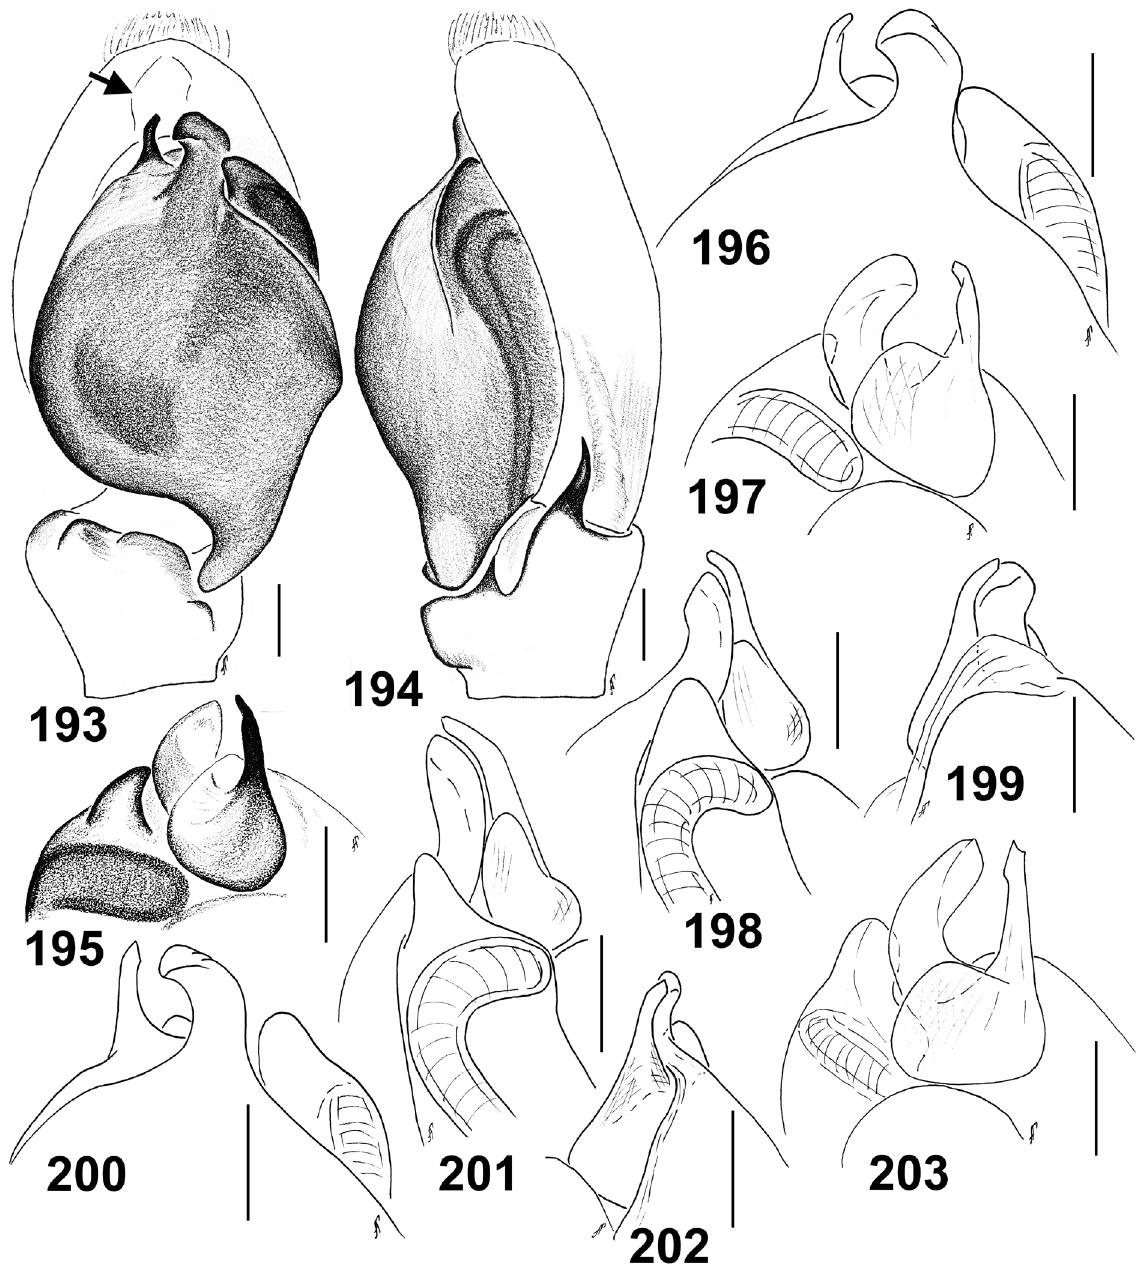
Figs 193–203. Male palp of Stenaelurillus guttiger (Simon, 1901). 193 . Ventral view. 194 . Retrolateral view. 195 , 197 , 203 . Embolic division, dorsal view. 196 , 200 . Embolic division, ventral view. 198 , 201 . Embolic division, retrolateral view. 199 , 202 . Embolic division, median view. Specimens: 193– 194, 196–199 from Botswana (Francistown; NCA 2009/3744); 195 from South Africa (Ophathe GR; NCA 2007/2973); 200–203 from South Africa (Ndumo GR; NCA 2006/1275). Scale bars: